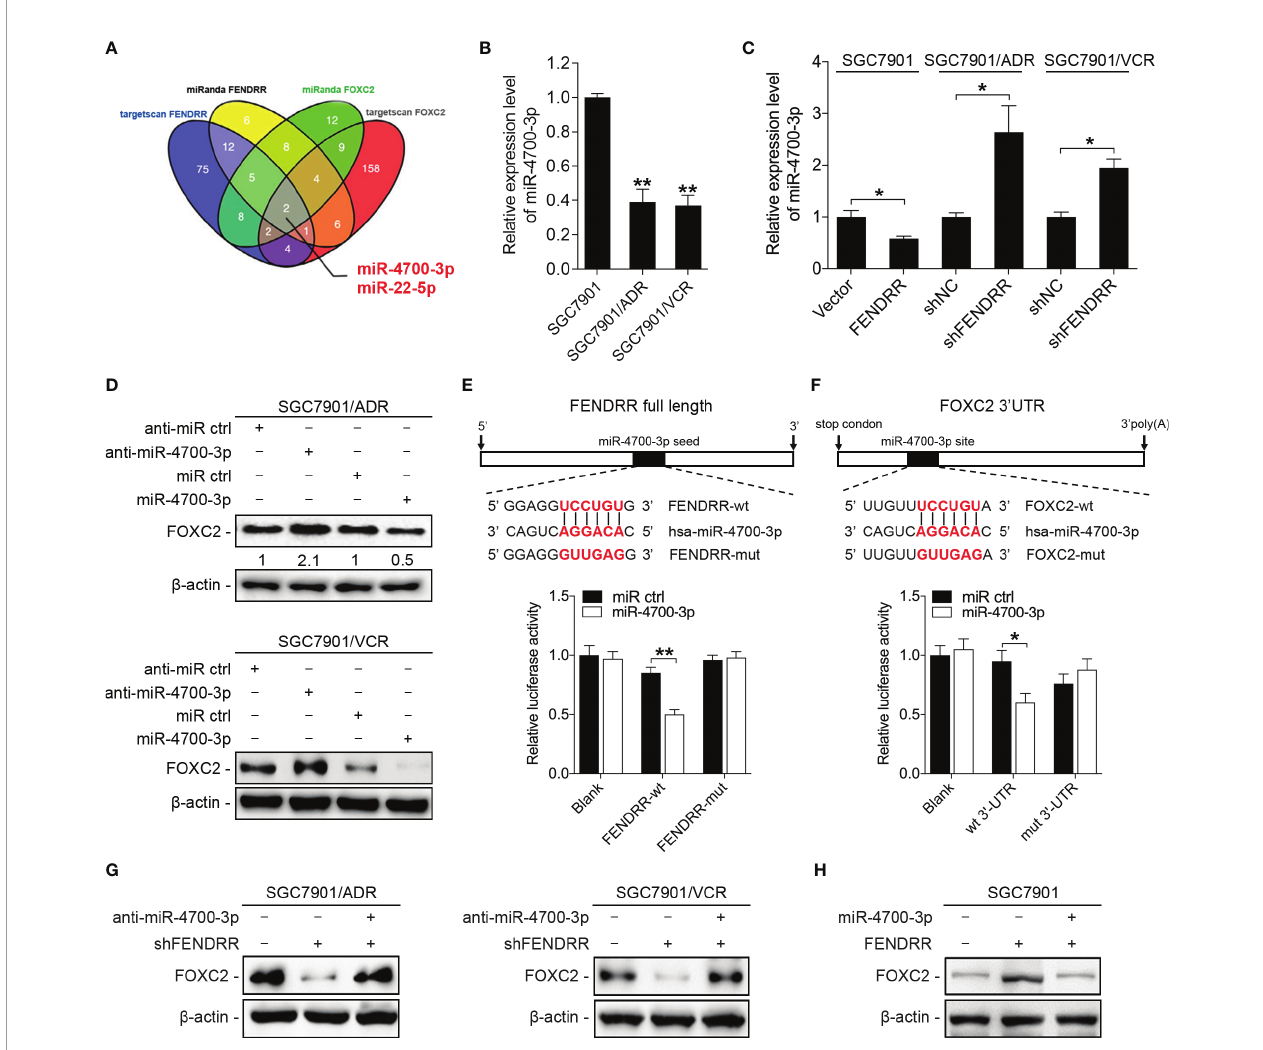
FIGURE 4 | FENDRR increases FOXC2 expression by competitively binding miR-4700-3p (A) Prediction of the potential miRNAs targeting both FENDRR and FOXC2 with two independent miRNA target databases. (B) qRT-PCR analysis of miR-4700-3p expression in the indicated cells. (C) The expression of miR-4700-3p following the downregulation or upregulation of FENDRR expression in the indicated cells. (D) Western blot analysis of FOXC2 expression in SGC7901/ADR and SGC7901/VCR cells transfected with miR-4700-3p mimics or inhibitors and the corresponding negative controls. (E, F) Predicted potential binding sites of miR- 4700-3p to FENDRR and FOXC2 are shown (upper panel). The wild-type (wt) and mutant (mut) miR-4700-3p target sequences of FENDRR (E) and FOXC2 (F) were fused to a luciferase reporter and cotransfected into HEK-293 cells with miR-4700-3p mimics or a negative control. Luciferase activity values were measured and normalized to empty vector control values. (G, H) Western blot analysis of FOXC2 expression in the indicated cells. ** P < 0.01, * P < 0.05, N.S. , not signi fi cant ( P > 0.05), error bars,